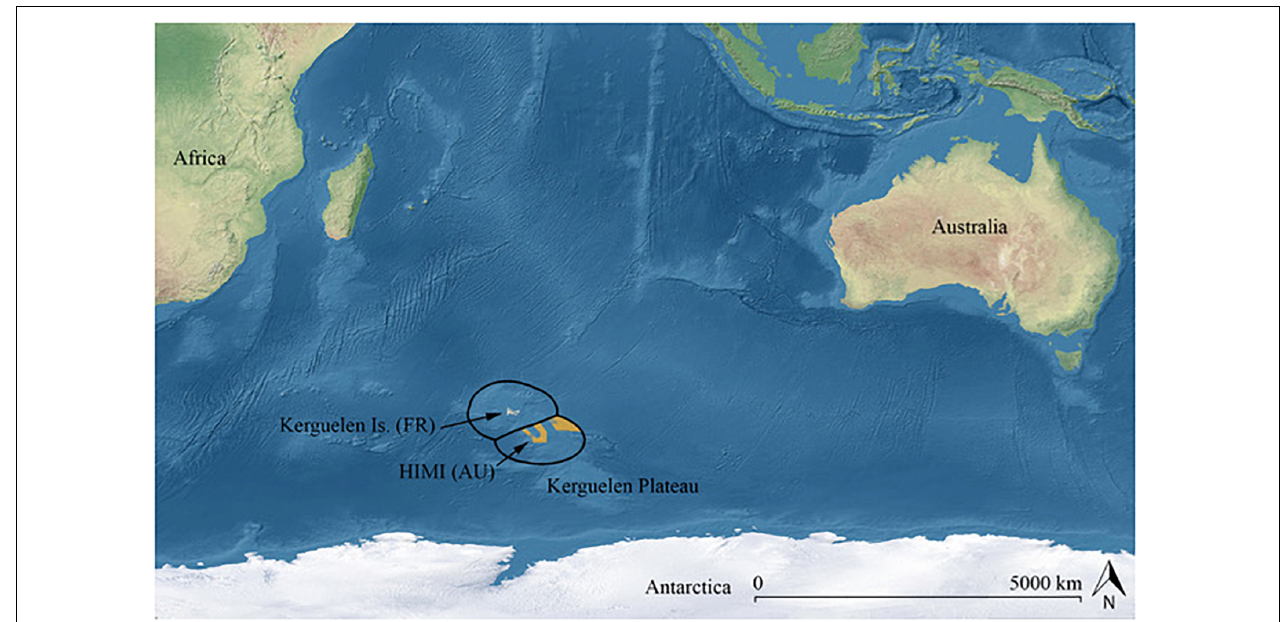
FIGURE 1 | The remote Heard Island and McDonald Islands (HIMI). HIMI are small subantarctic islands on the Kerguelen Plateau located ∼ 4,000 km southwest of Australia and ∼ 1,600 km north of Antarctica. The original HIMI Marine Reserve (65,000 km2) is shown in orange (note that the boundaries of the MPA were expanded in 2014). The Australian governed HIMI is adjacent to the French Kerguelen Islands. Australia’s Exclusive Economic Zone (EEZ) and the adjacent French EEZ, are illustrated by the black circular